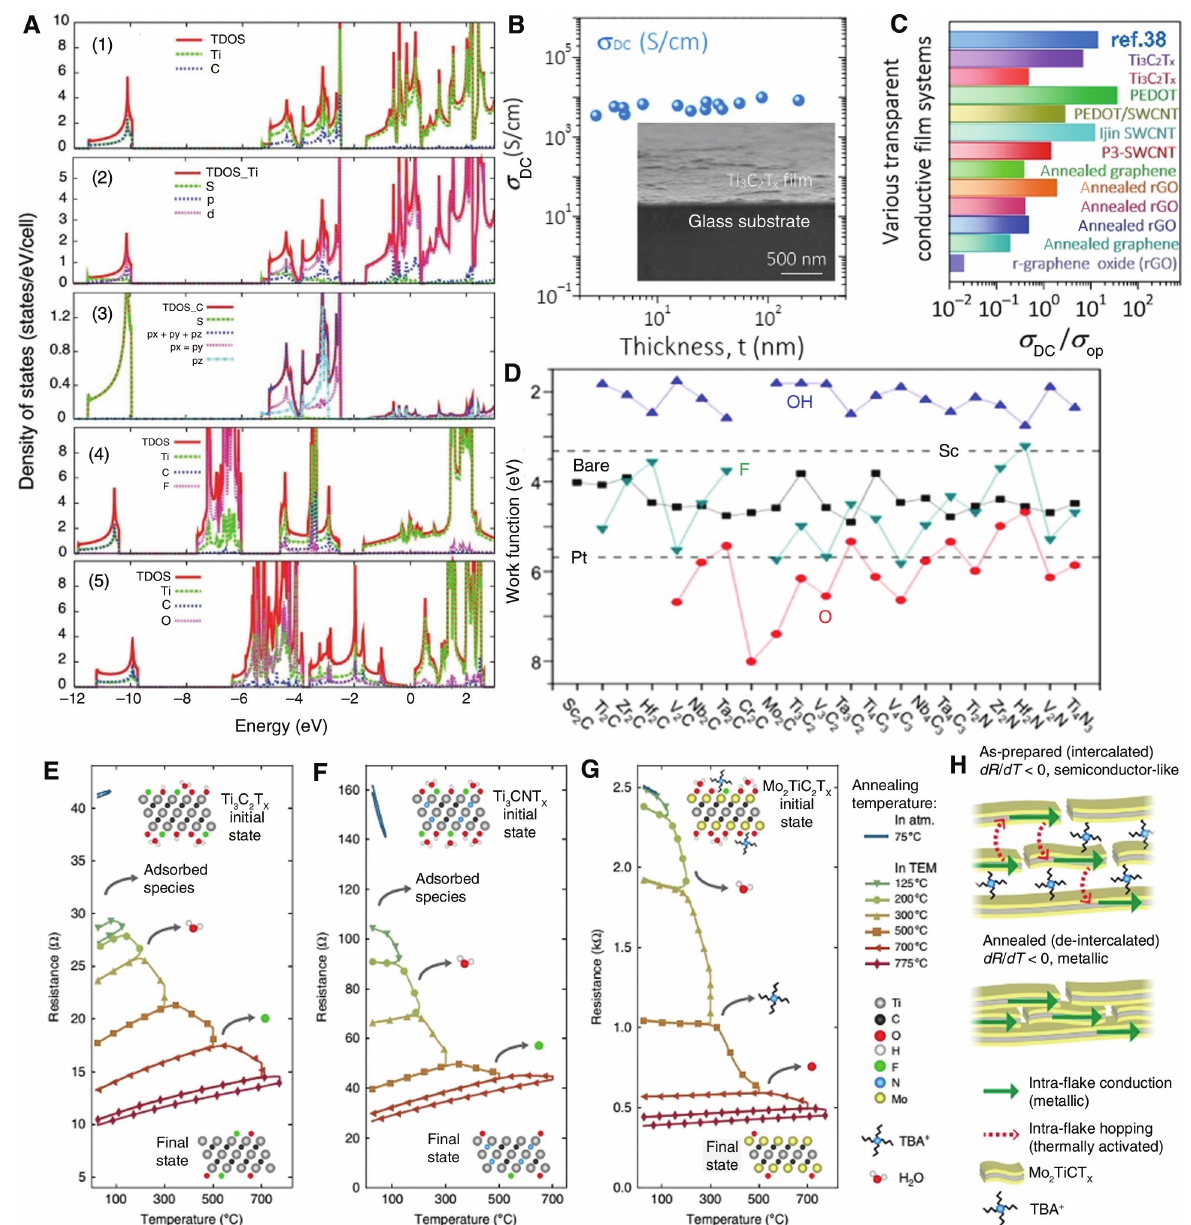
Figure 5: Electronic properties of MXenes modified by functional groups. (A) DOS of Ti C (1), PDOS on atomic orbitals of Ti (2) and C atoms (3). DOSs of Ti CF (4), and Ti CO (5). Fermi energy is zero. 2 2 2 2 2 For the semiconductors, it is shifted to the center of the gap. (B) DC conductivity of Ti C T films with different thickness and cross-sectional 3 2 x SEM image of spun-cast Ti C T film (inset). (C) Comparison of σ / σ in Ti C T films to various other TCEs. The bars are color-coded based 3 2 x DC op 3 2 x on reported values. (D) Work functions of MXenes with various terminations. Bare surface: black square; O termination: red circle; OH termination: blue up-triangle; F termination: cyan down-triangle. (E–G) Results of MXene conductivity with in-situ vacuum annealing. Resistance vs. temperature measurements are shown for Ti C T (E), Ti CNT (F), and Mo TiC T (G). (H) Schematic illustration of intercalant 3 2 x 3 x 2 2 x effect for electronic conduction of multi-flake Mo TiC T . (A) Reproduced with permission [67], Copryright 2013, Weily-VCH. (B–C) Reproduced 2 2 x with permission [40], Copyright 2017, Weily-VCH. (D) Reproduced with permission [69], Copyright 2016, American Chemical Society. (E–H) Reproduced with permission [126], Copyright 2019, Nature Publishing